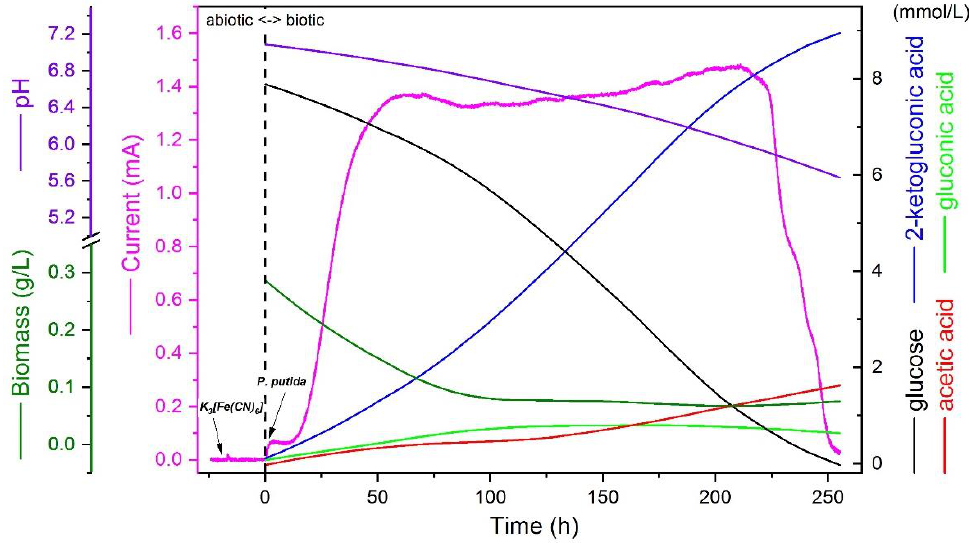
Figure 3. Typical raw results of the short-batch BES cultivation of Pseudomonas putida F1 with glucose as the sole carbon source (averaged from triple reactors). Ferricyanide of 1mM is used as the mediator and the working electrode potential is set at 0.5 V vs Ag/AgCl/KCl sat . Right Y axis indicates the concentrations of different compounds in the broth quantified by HPLC. They need to be adjusted with a concentrating factor because of the water loss caused by gas flushing (0.09 mL/h) while conducting carbon and electron balance (both balanced for the presented data) based on those data. Supplementary Materials: The following files are available online at www.mdpi.com/xxx/s1, Figure S1: Cyclic voltammetry characterization of carbon cloths with different pre-treatment methods, Figure S2: Growth property of Pseudomonas putida F1 in shake flasks with different gas-permeable stoppers in minimum mineral medium.